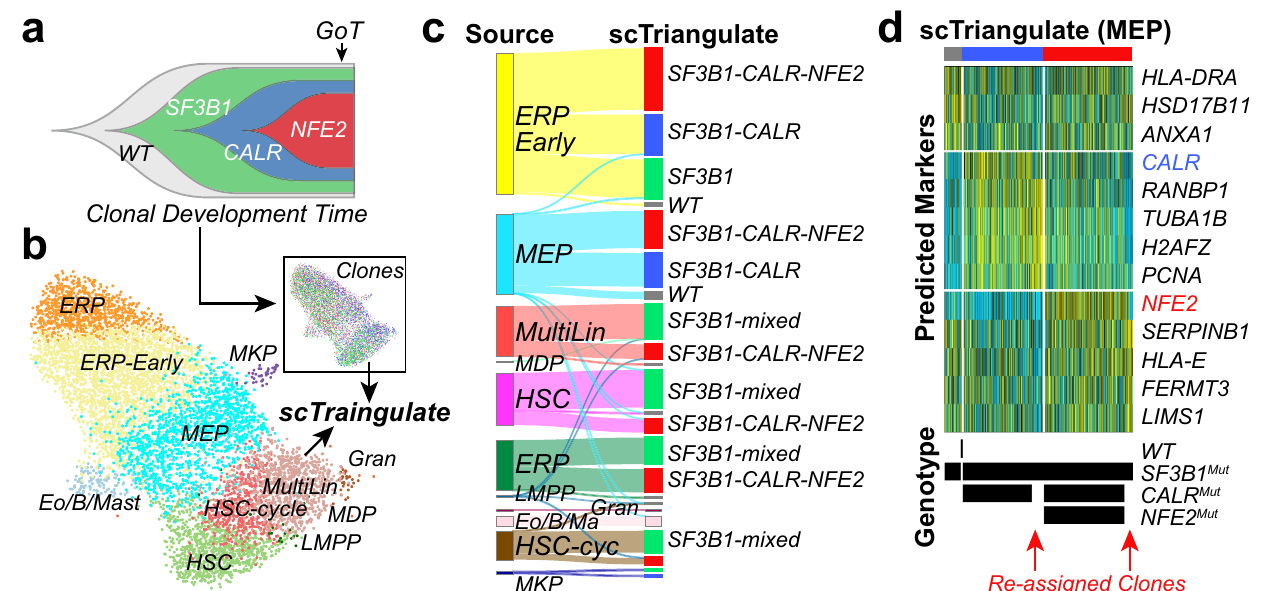
Fig. 6 | Detection of cell-state-speci fi c clonal impacts from genotyping-of- transcriptomes. a Fish-plot displaying the clonal evolution of a patient with one (SF3B1), two (SF3B1-CALR), or three (SF3B1-CALR-NFE2) causal MPN mutations. GoT (arrow) indicates when single-cell pro fi ling and genotyping were performed. b MPN single-cell clusters assigned by supervised assignment (cellHarmony) rela- tivetohealthybonemarrowCD34+progenitors,withtheclonalarchitectureofthe